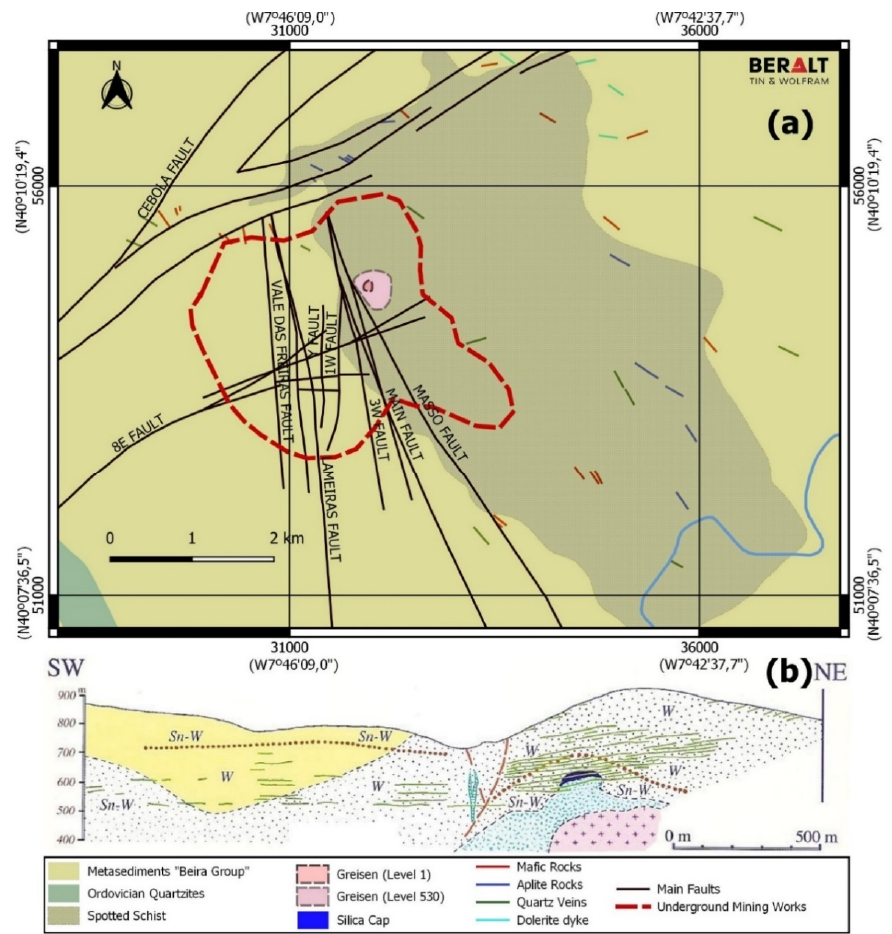
Figure 2. Geological map of the Panasqueira mine area ( a ) and geological cross-section of the Barroca Grande sector ( b ), across the swarm of quartz lodes bordering the greisen-granite cupola (dotted pattern fill with a light-blue foreground); in this cross-section, the spotted schists are indicated by the dotted pattern filled with the black foreground and separated from the other metasediments (in yellow). Adapted from the official map of Beralt Tin and Wolfram Portugal, after [56,57,69]. The mined quartz (± topaz ± white mica ± tourmaline ± siderite) lodes are irregularly distributed in a global volume that extends for ca. 2500 m in length, ca. 400 to 2200 m in width, and ca. 500 m in depth (Figure 2B). Prevalent lodes are subhorizontal (8° to 10° SW) and display an average thickness